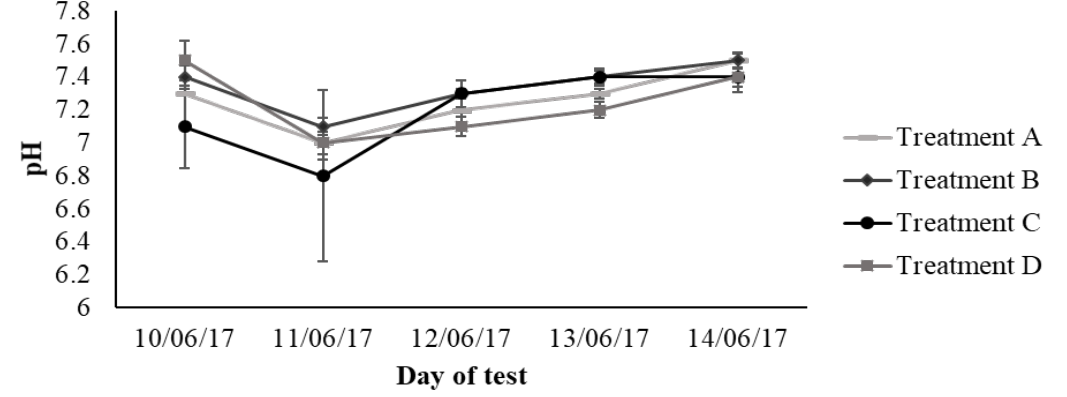
Figure 3. The mean pH values recorded during the ammonium volatilisation test. Treatment A (constant aeration), Treatment B (intermittent aeration 4h AA:4h no-AA), Treatment C (intermittent aeration 6h AA:4h no-AA), Treatment D (no aeration), AA = aeration.